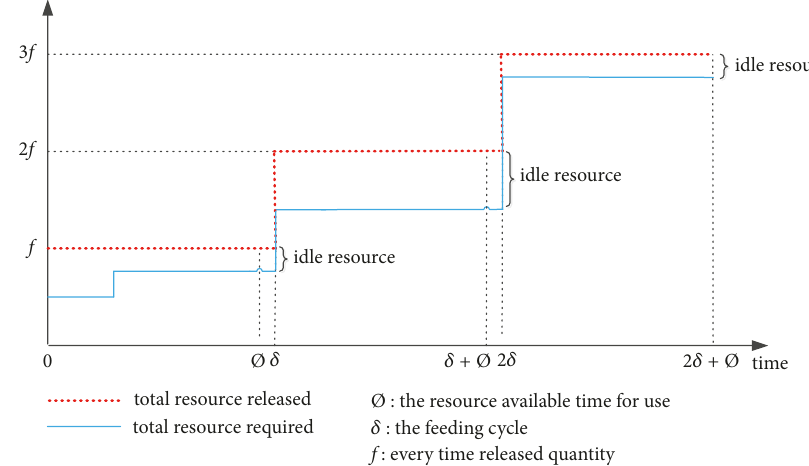
Figure 3: Resource available time constraints in continuous-casting